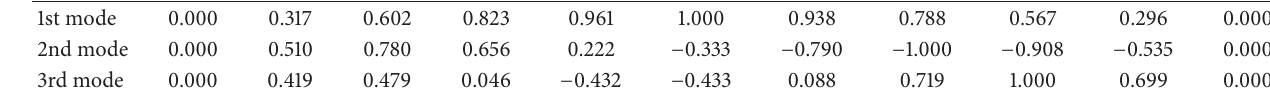
Table 14: Optimal mode shapes (Case 2B).